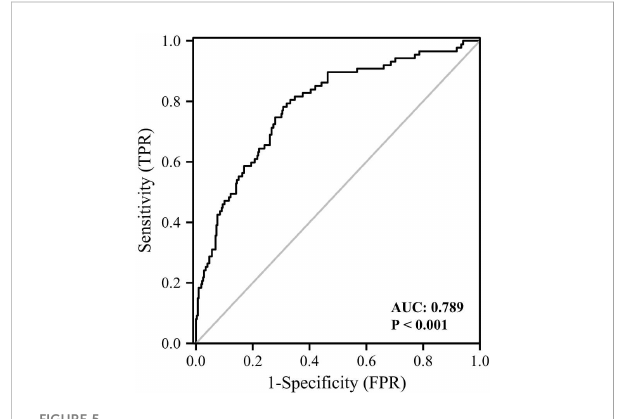
FIGURE 5 ROC curve analysis of the ability of plasma GPNMB and the presence of diabetes together to predict the presence of cataract. AUC, area under